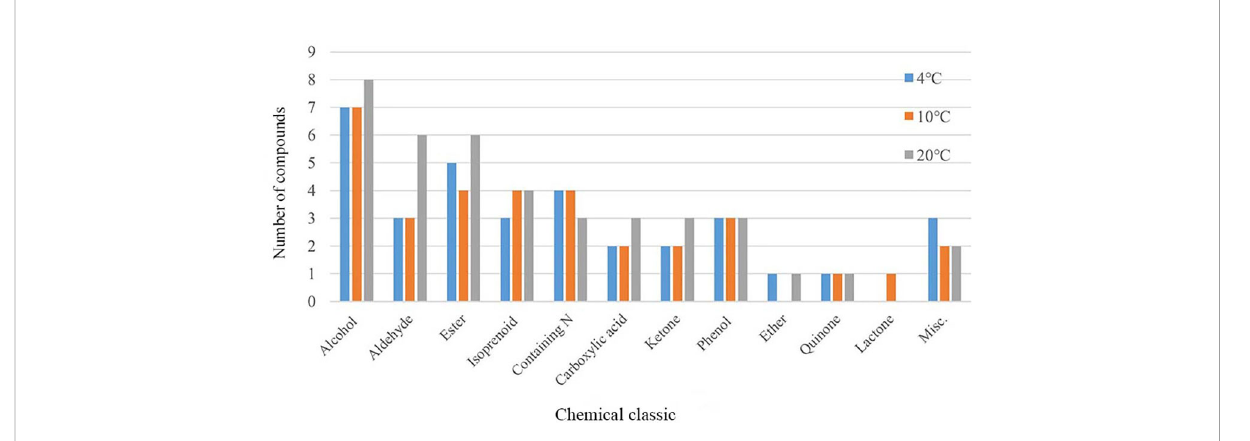
FIGURE 3 Chemical group distribution of VOCs produced by yeasts at varying